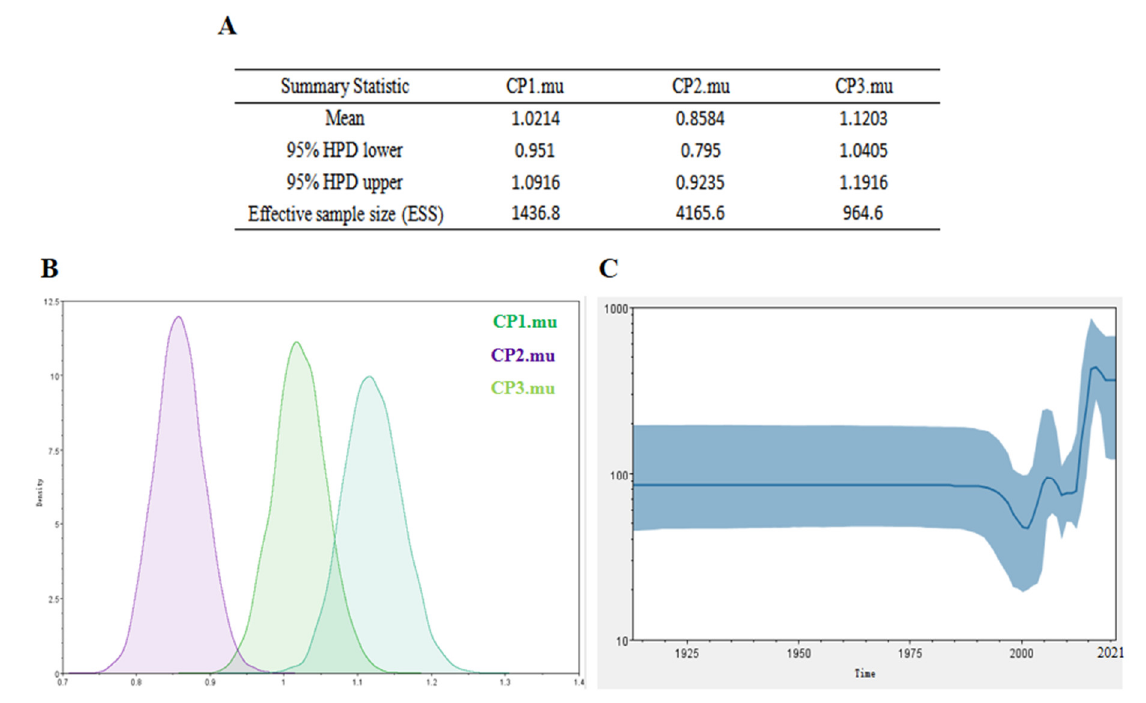
Figure 2. PPV virus structural protein codon mutation rate and skyline diagram ( A , B ). The codon mutation rate of PPV virus structural protein gene was estimated by Bayesian Markov chain method. The codon mutation rate is the result of BEAST running using Trace analysis. ( C ) The dynamic study of the genetic diversity of PPV virus structural protein genes by Bayesian skyline diagram. The thick solid line is the median estimate, and the dashed line represents the 95% confidence interval. The abscissa is time, and the ordinate is the effective population size. Table 1. Properties of structural protein genes from PPV strains analyzed in this study (mean value ± SD).